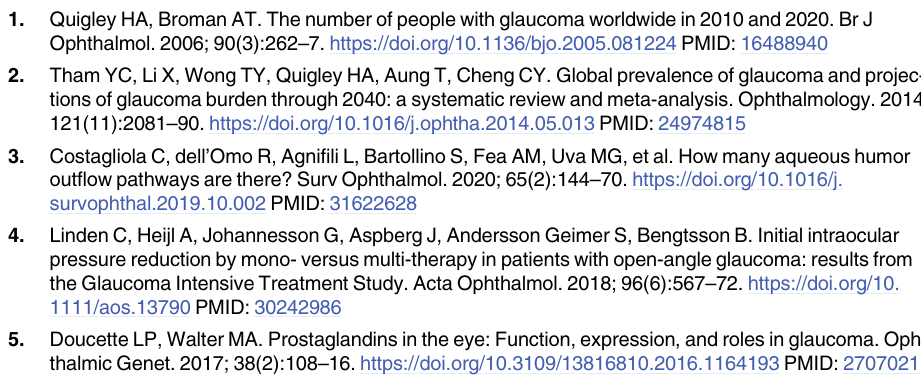
S3 Fig. ssAAV2-STC-1-FLAG does not affect episcleral venous pressure or uveoscleral out- flow. 3-month-old C57BL/6J mice were randomized to receive either a single injection of intracameral ssAAV2-STC-1-FLAG (n = 5;3x10 9 VG)) or ssAAV2-GFP (n = 5; (3x10 9 VGs) or daily topical STC-1-FLAG (n = 4), LFA (n = 5) or no treatment (n = 4) in one eye. Aqueous humor dynamics was performed at maximal treatment response (week 6 for injection experi- ments and day 5 for topical experiments). A) No significant difference among any treatment groups was seen with respect to episcleral venous pressure, B) uveoscleral outflow, or C) Aque- ous humor formation